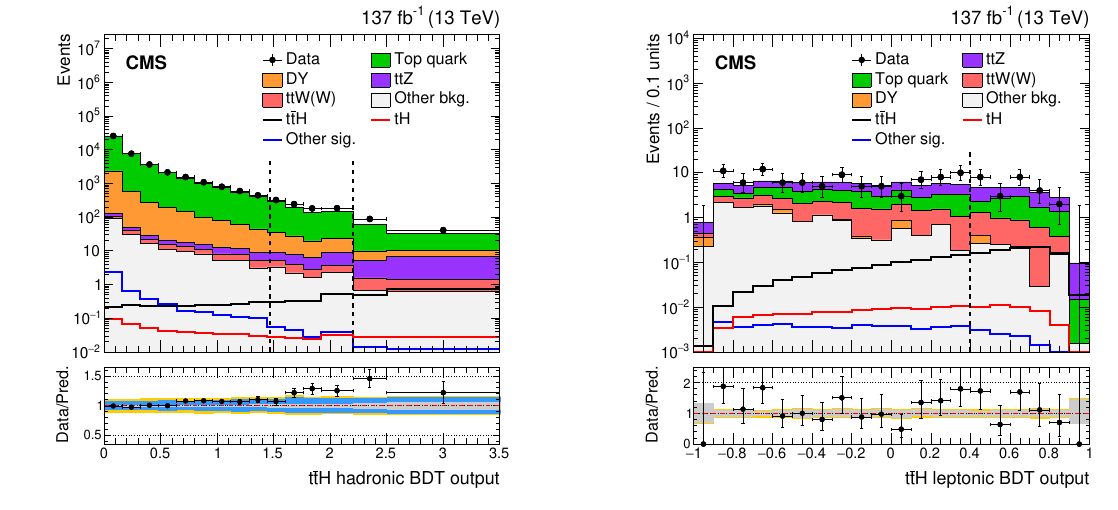
Figure 6 . The observed BDT output distribution in the ttH hadronic (upper) and leptonic (lower) categories compared to the prediction from the simulation of various SM background processes. Sig- nal distributions expected from different production modes of the Higgs boson with m are overlaid. The dashed vertical lines indicate the boundaries of the optimized event